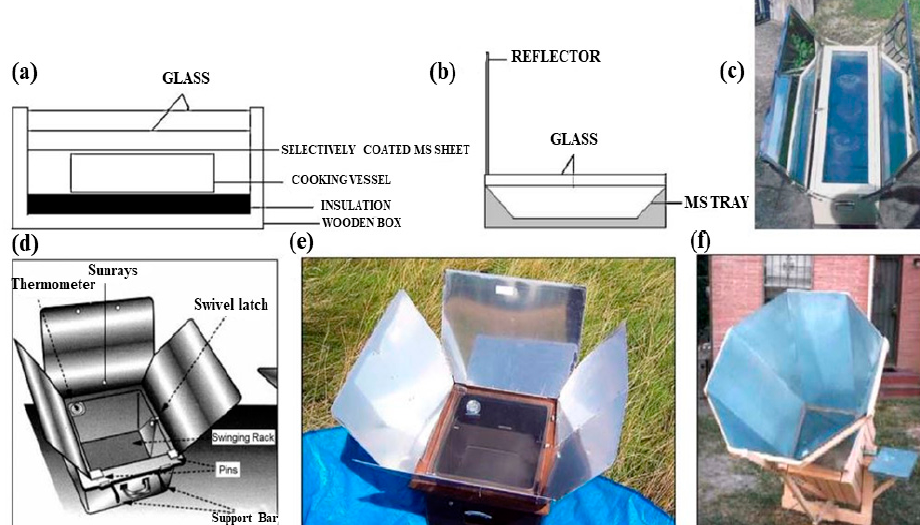
Figure 6. Pictures of solar cooker developed: ( a ) Simple box with glazed glass lid and insulated bottom; ( b ) Single-reflector box-type solar cooker; ( c ) Twin-reflector solar cooker; ( d ) Simple four- faced-reflector solar cooker; ( e ) Four-faced-reflector solar cooker with Swinging rack; ( f ) Multi-faced conical reflector solar cooker . Reprinted/adapted with permission from [8], 2010, Elsevier.